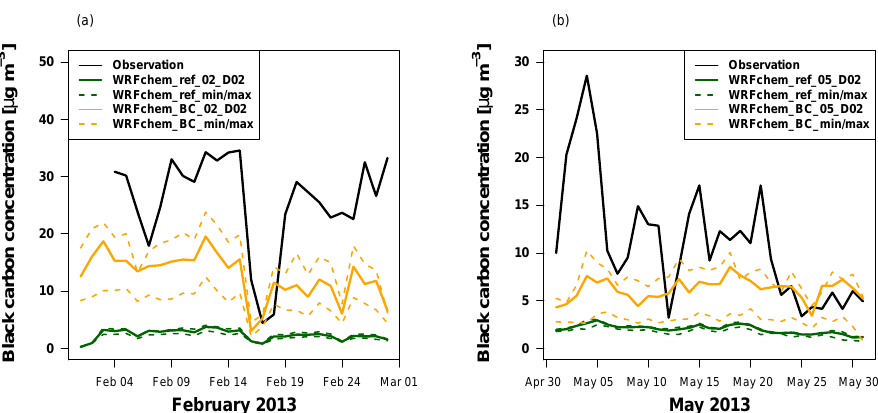
Figure 13. Time series of daily mean measured and simulated (WRFchem_ref_02/05_D02, WRFchem_BC_02/05_D02) black carbon con- centrations (µgm − 3 ) at the Bode station for February (a) and May (b) 2013.